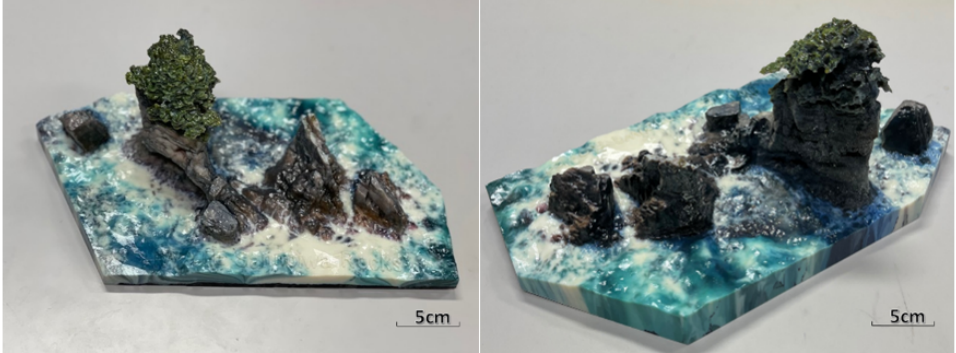
Figure 16. Three-dimensional model printed by Stratasys J750.